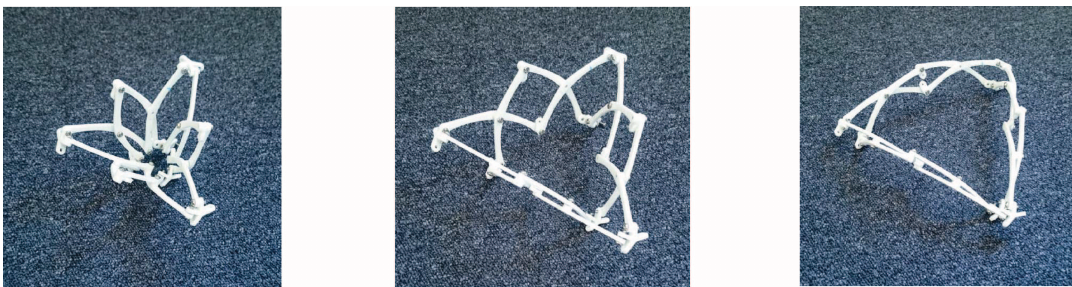
Figure 5. Physical prototype models with variational play to understand the stages of motion from closed to